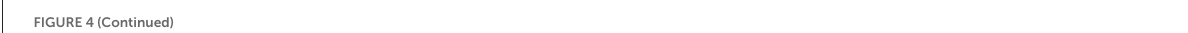
FIGURE4(Continued) and the start of the gastric phase. The column charts present the results of intestinal digestion of gastric digested emptied at 50 (E1), 100 (E2) and 150 (E3) min. Results of the control experiments are presented on the left. Results obtained with the supplemental enzyme mix